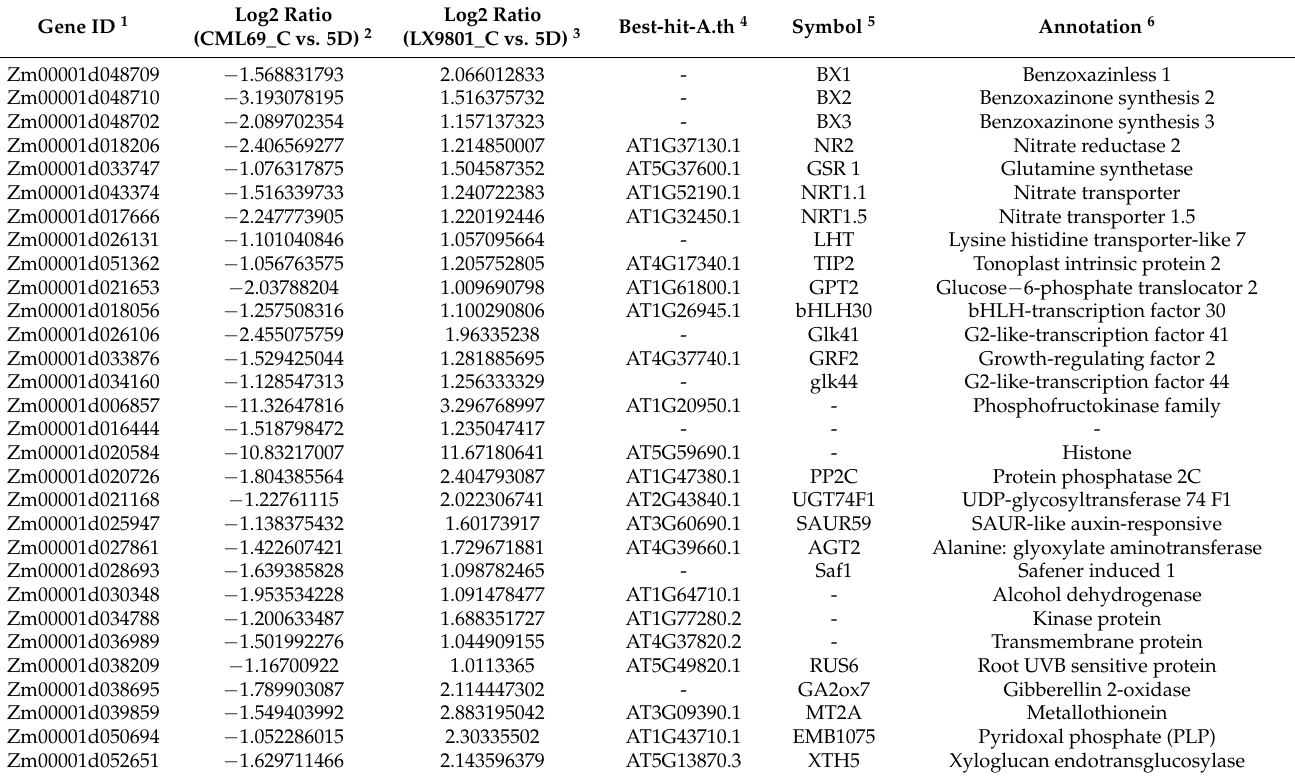
Table 7. Thirty drought-responsive DEGs downregulated in CML69 but upregulated in LX9801 at 5D drought